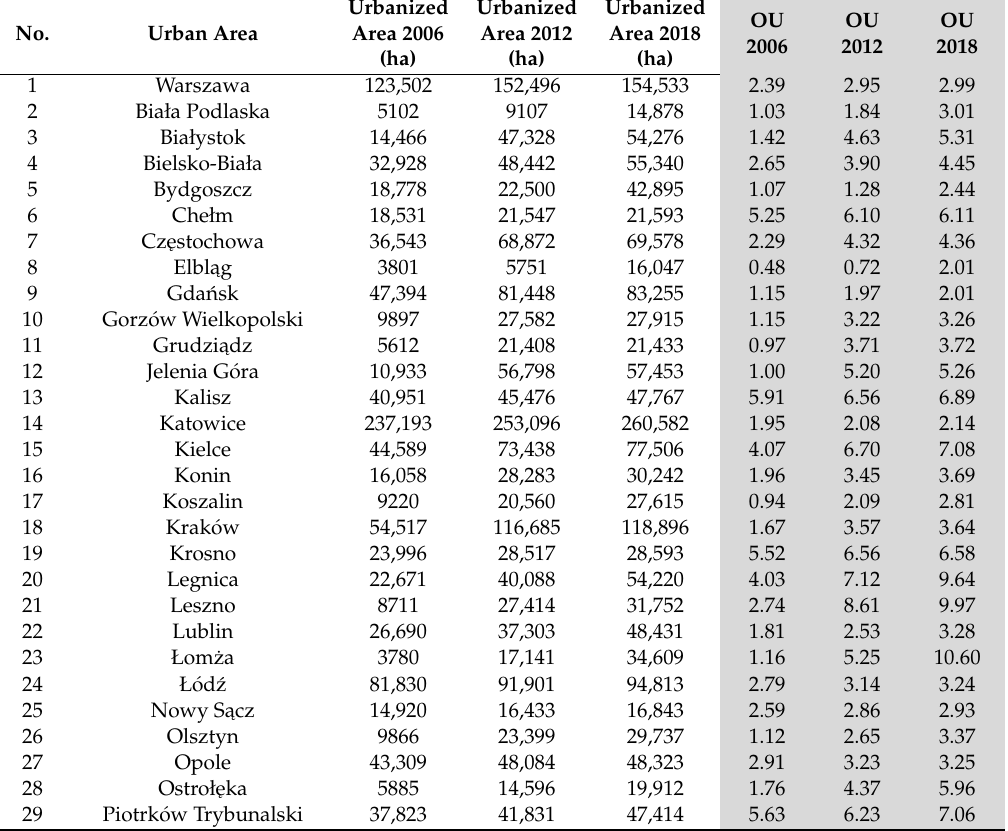
Table A2. Overgrowth of urbanization index in 2006, 2012 and 2018. The calculated indicators OU for 2006, 2012 and 2018 are marked in